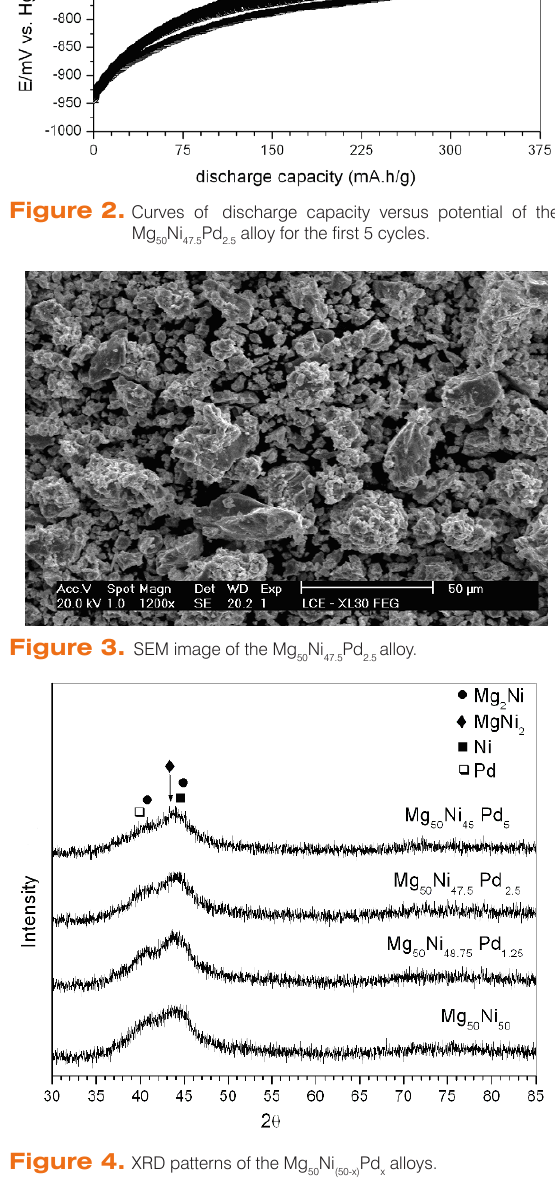
Ni Pd 50 (50-x) x